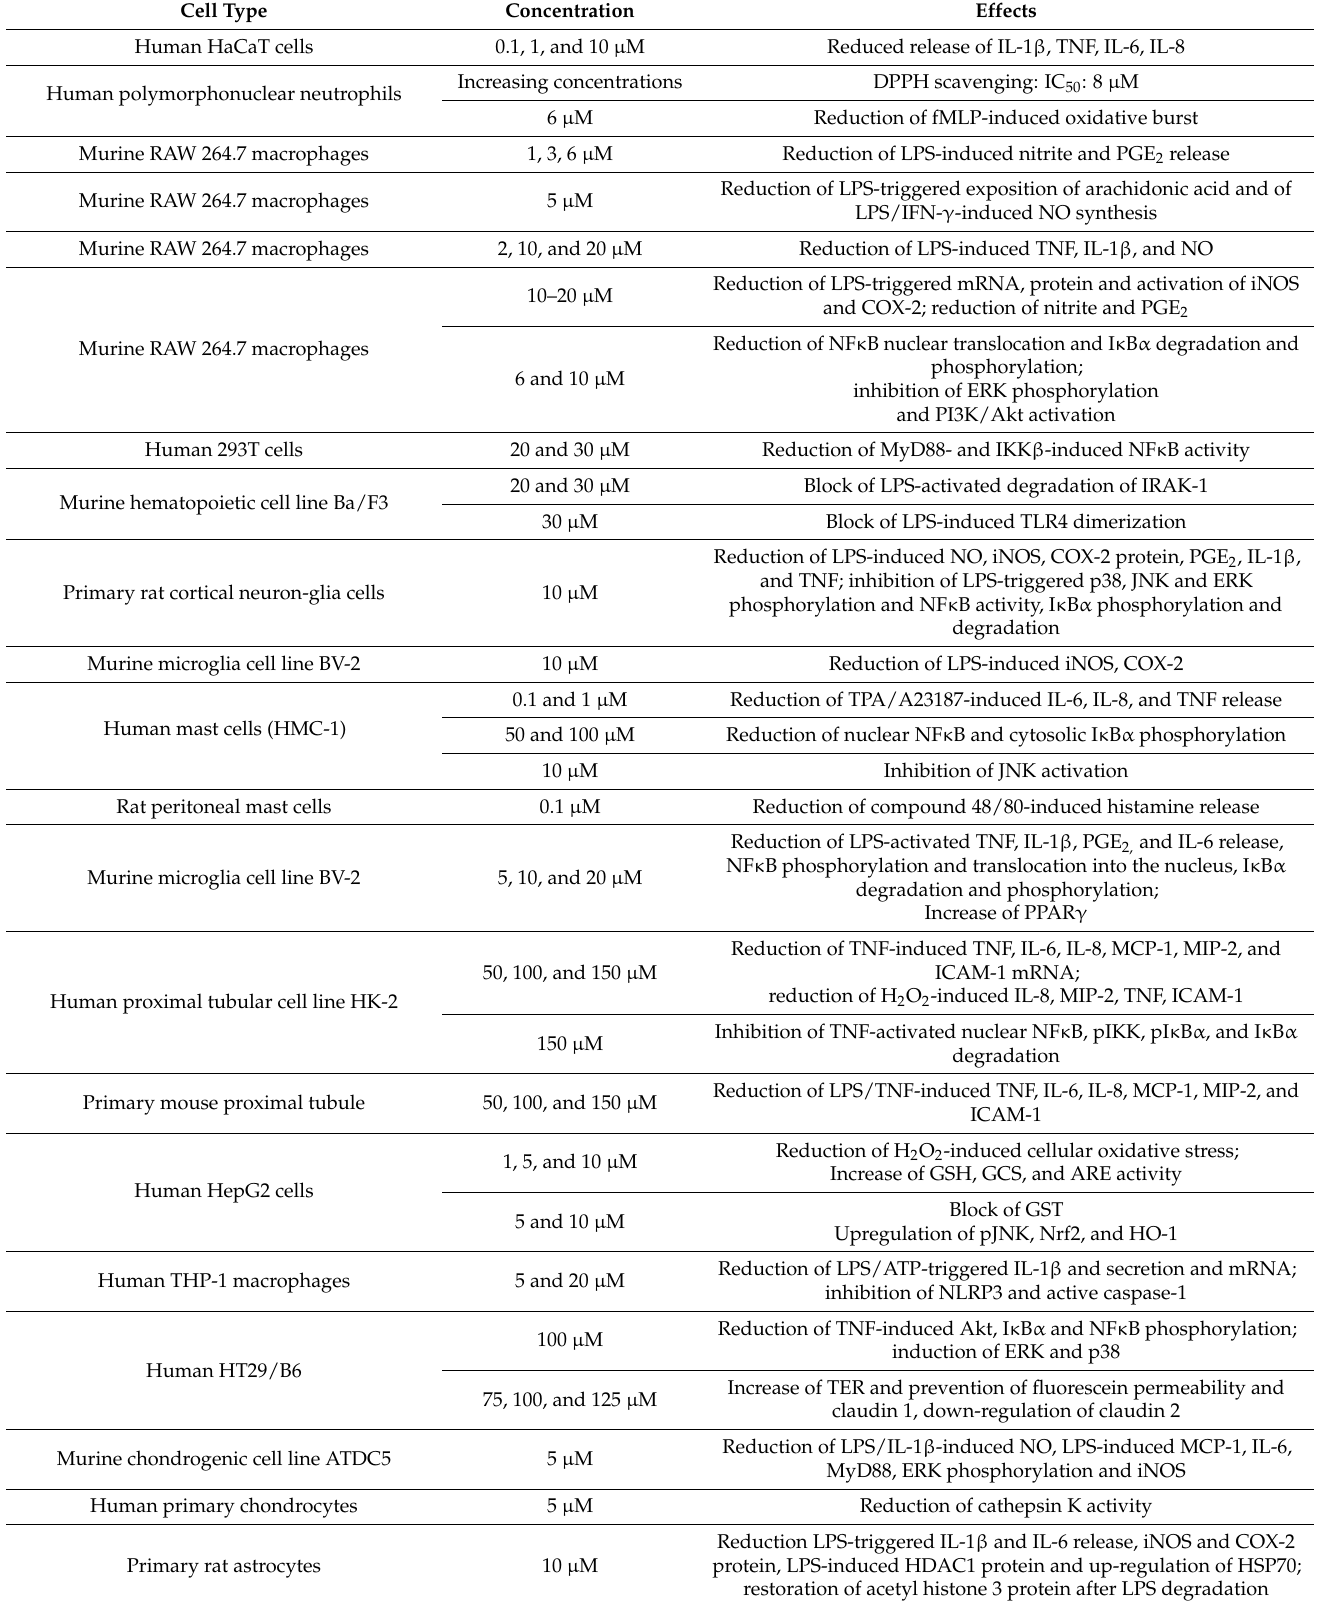
Table 3. In vitro anti-inflammatory effects of